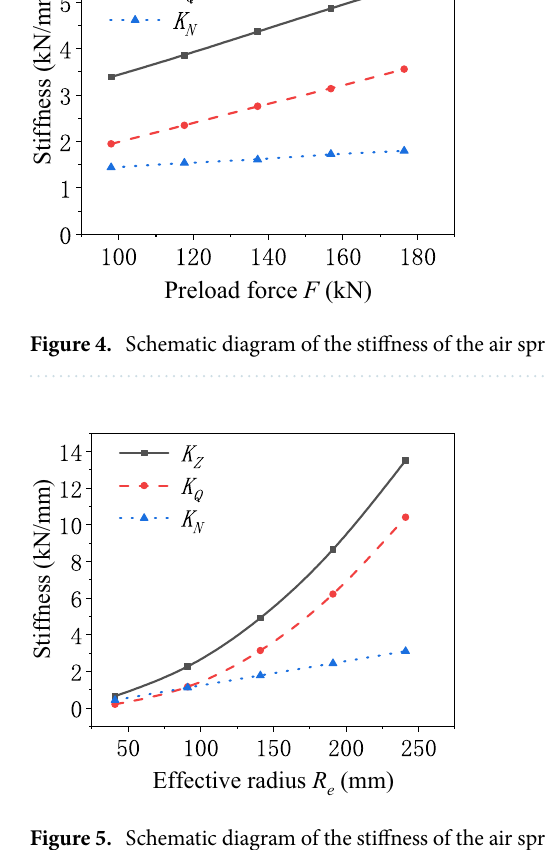
Figure 5. Schematic diagram of the stiffness of the air spring varying with the effective